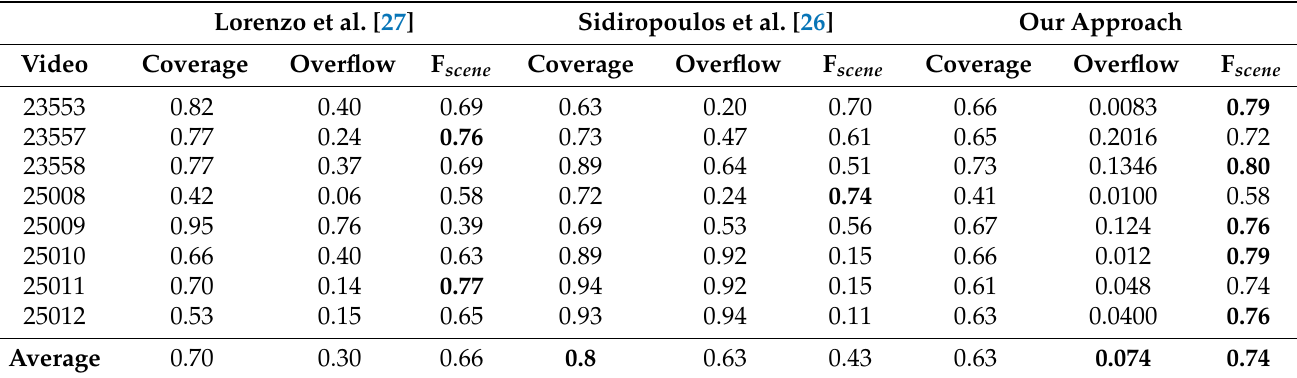
Table 2. Performance comparison for LSU detection using frame-level metrics. Lorenzo et al.